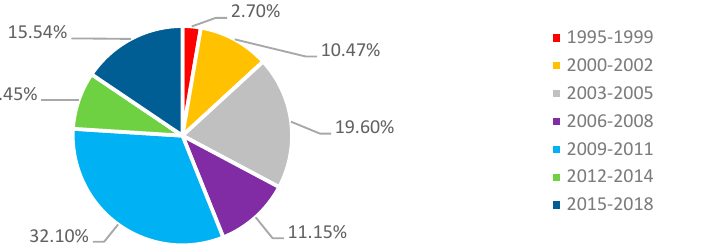
Figure 3. Breakdown of the public bus fleet in Szczecin in 2018 by year of manufacture [%].